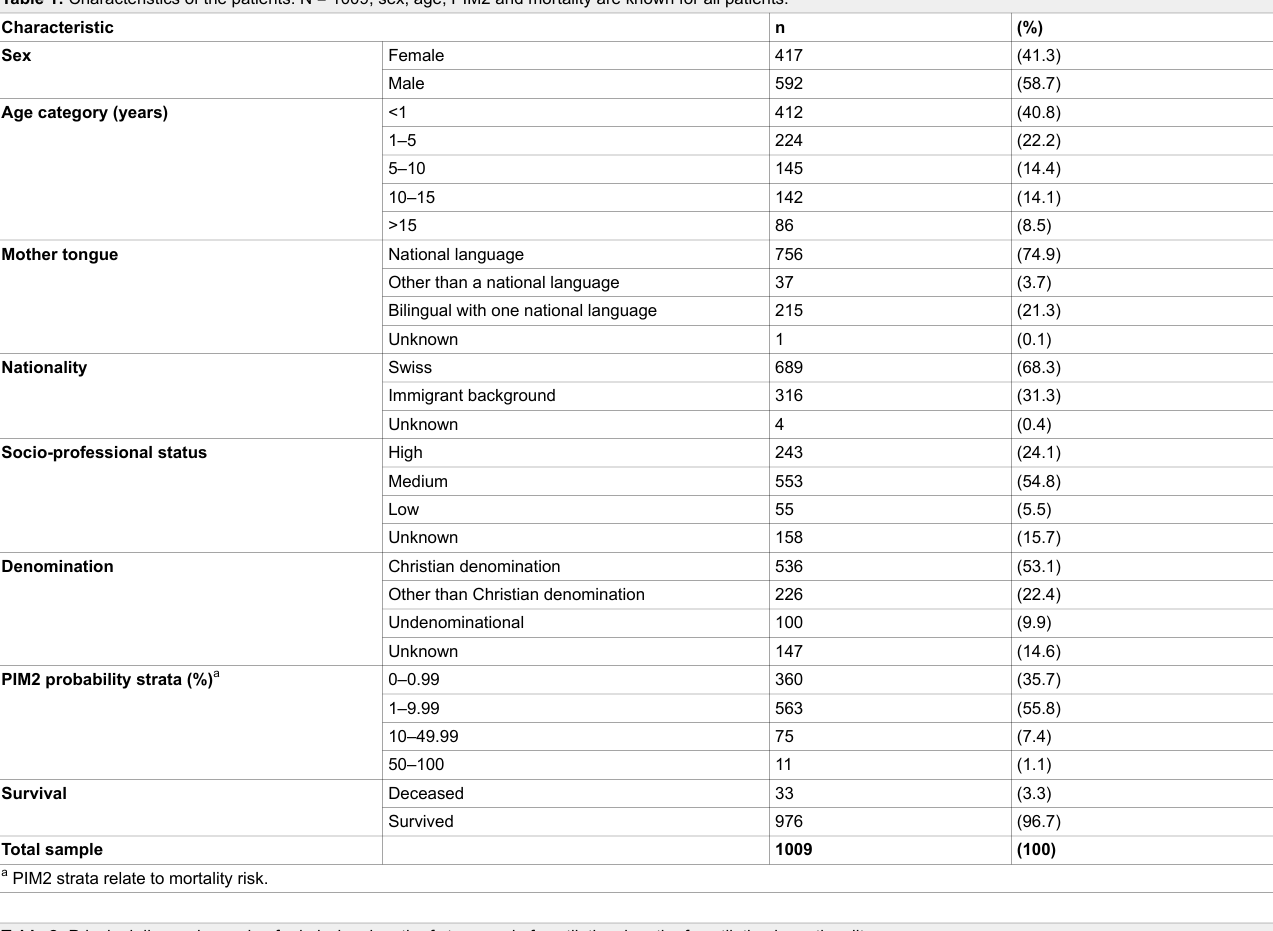
Table 1: Characteristics of the patients. N = 1009; sex, age, PIM2 and mortality are known for all patients. Characteristic